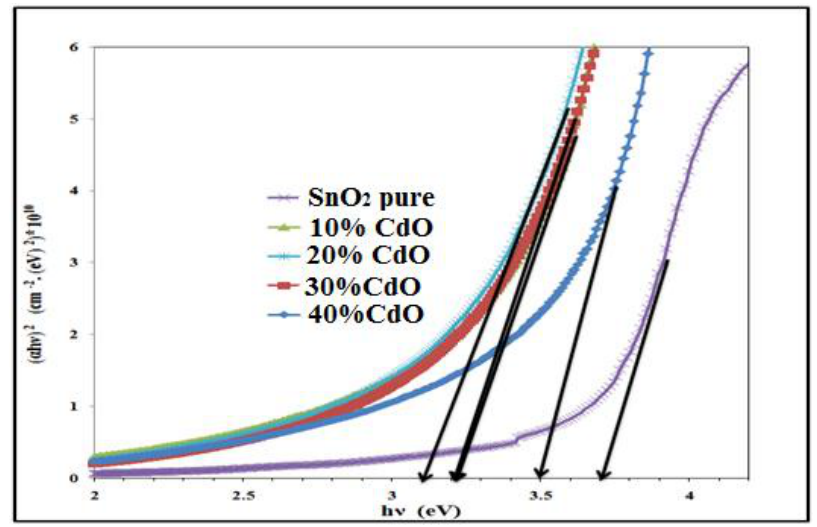
Fig. 4: Energy gap for SnO